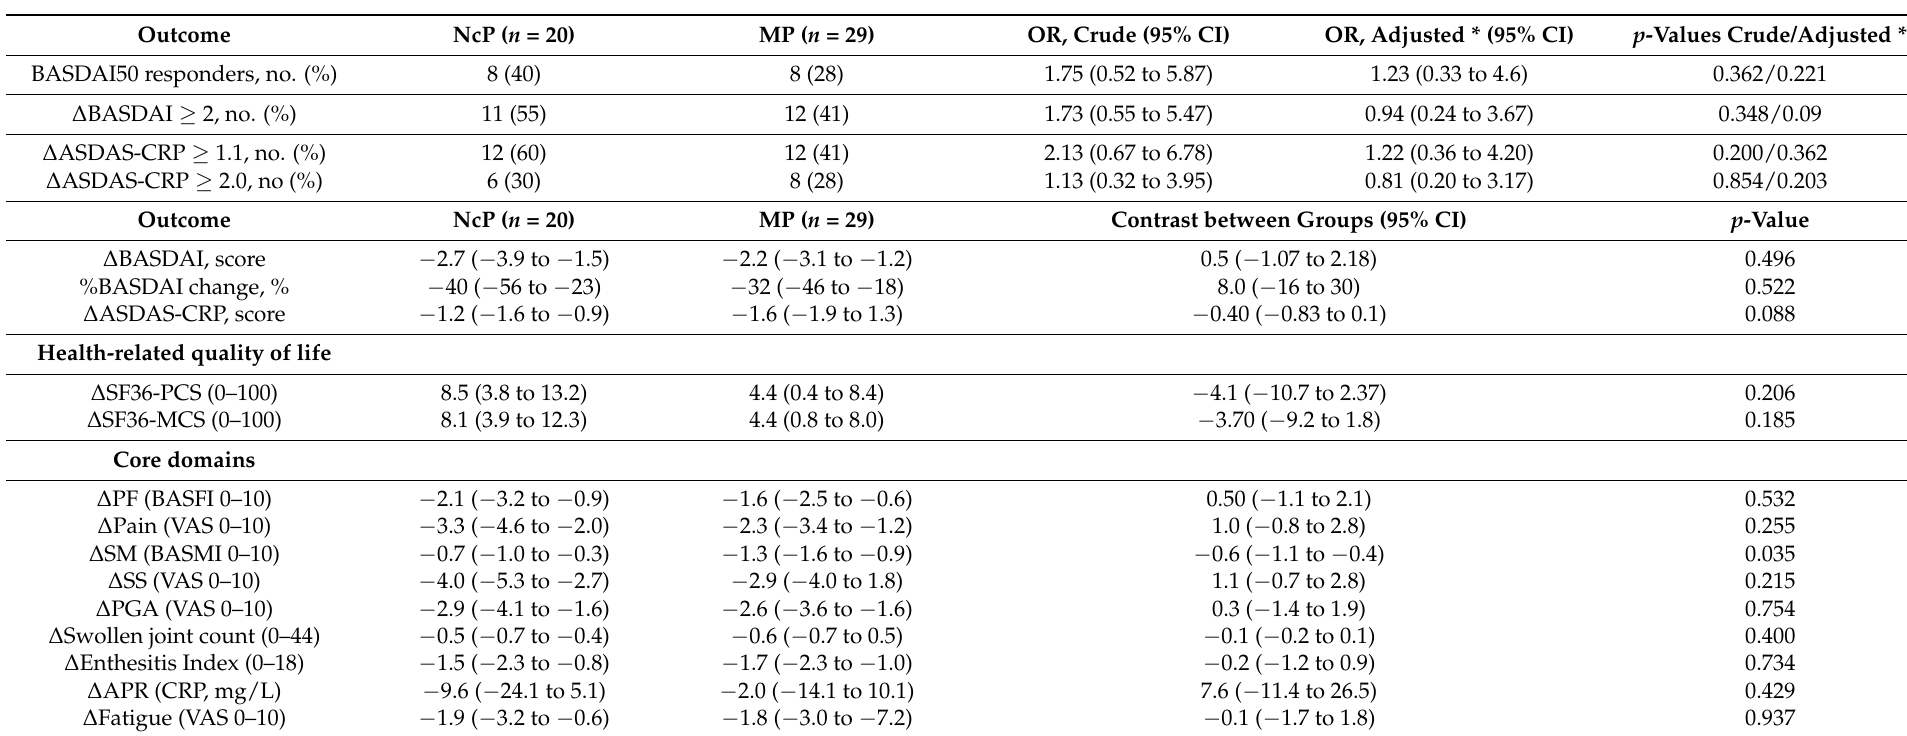
Table 2. Change in BASDAI responses and axSpA core domains stratified by pain phenotype at enrolment in the Intention-to-Treat (ITT)